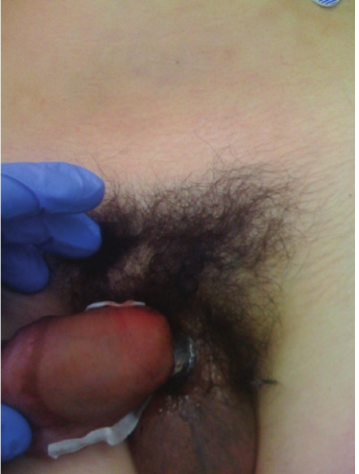
Figure 1: Patient at presentation, note distal penile edema.